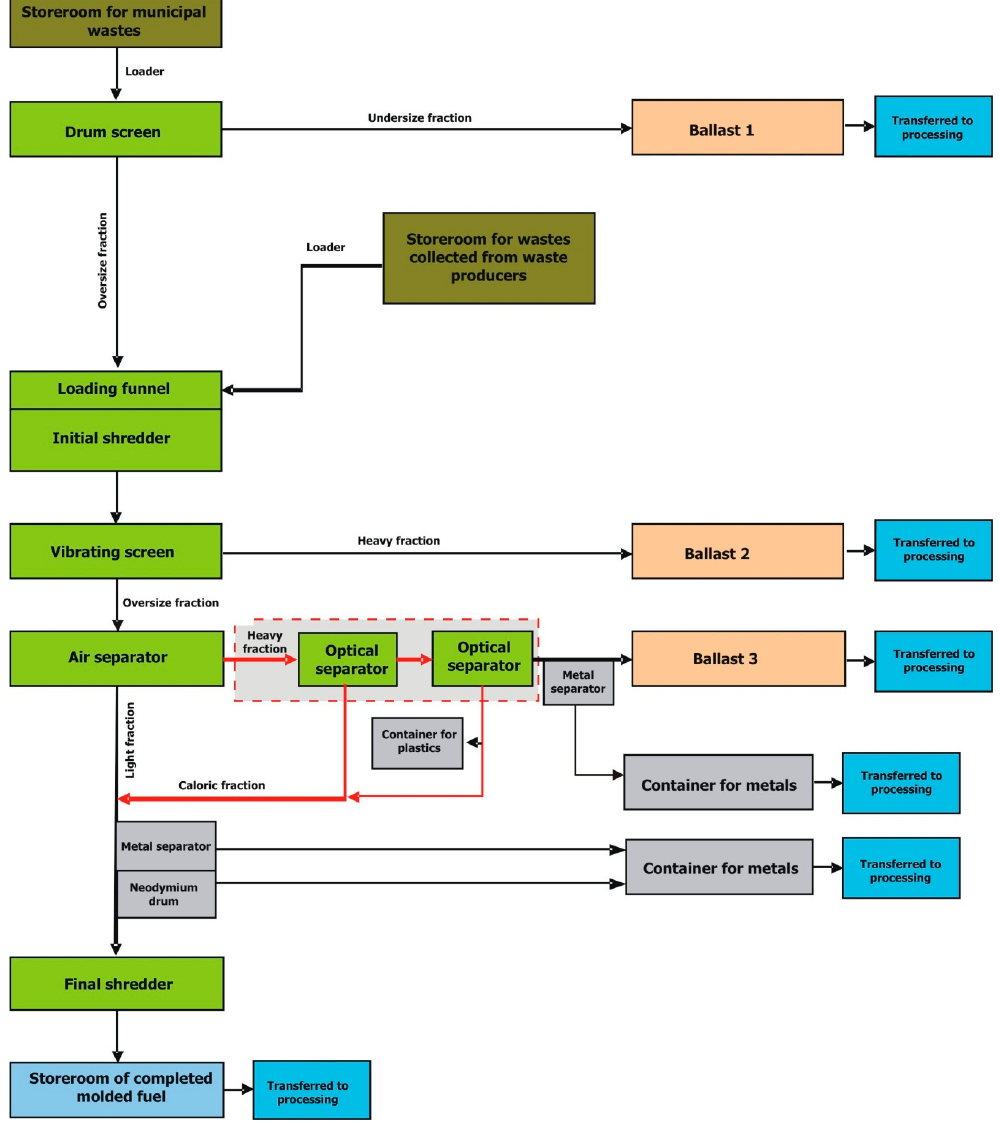
Figure 8. Block diagram of the process of municipal waste segregation with the production of the formed fuels [own elaboration].